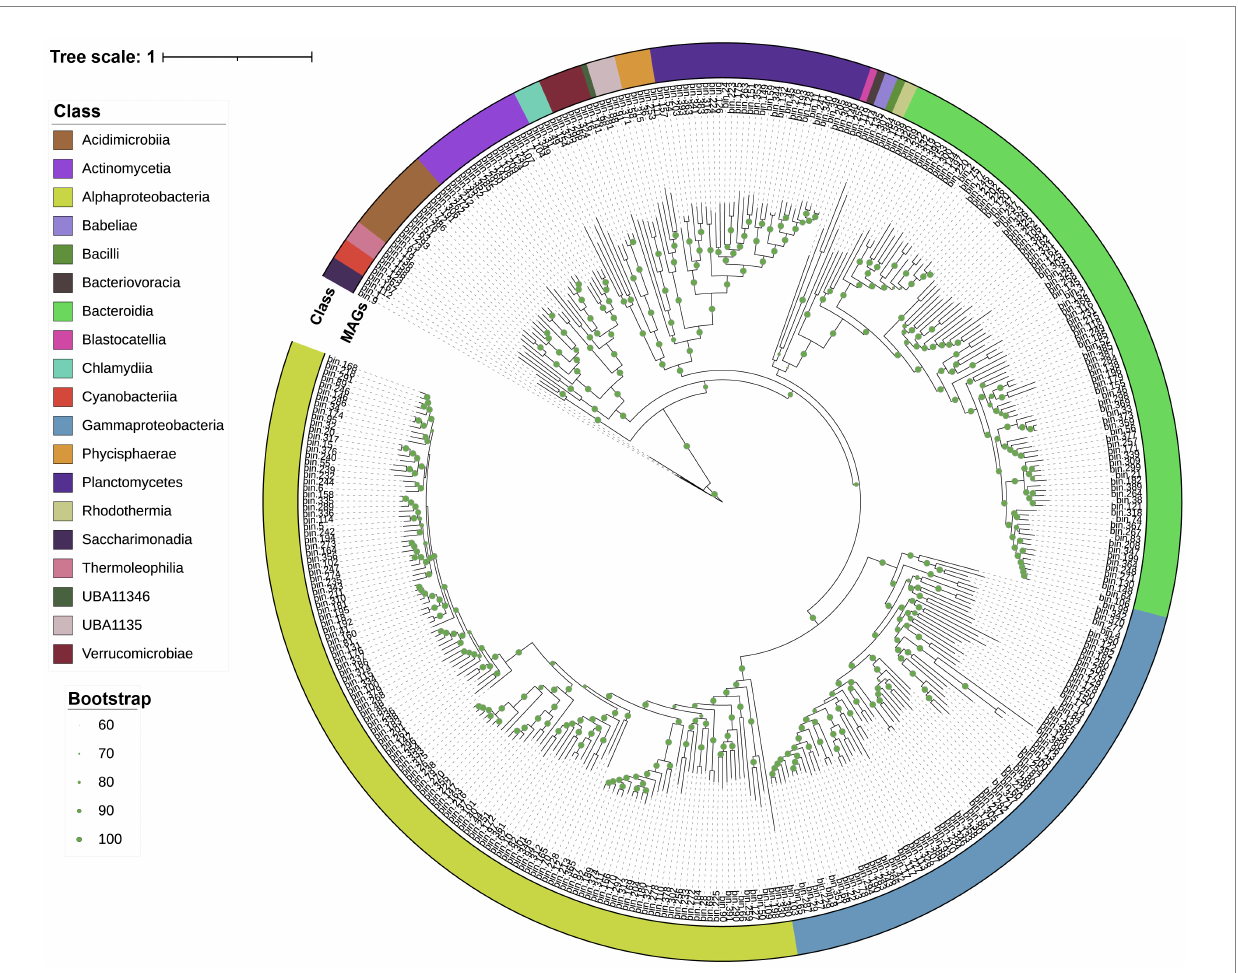
FIGURE 2 The maximum-likelihood tree based on conserved genes. Taxonomic classifications were determined using GTDB-tk. The external ring (colored) indicates the bacterial taxonomy (i.e., class information) to which the MAGs belong. Branch labels display the temporary name for the MAGs. Green dots represent branch support values between 60 and